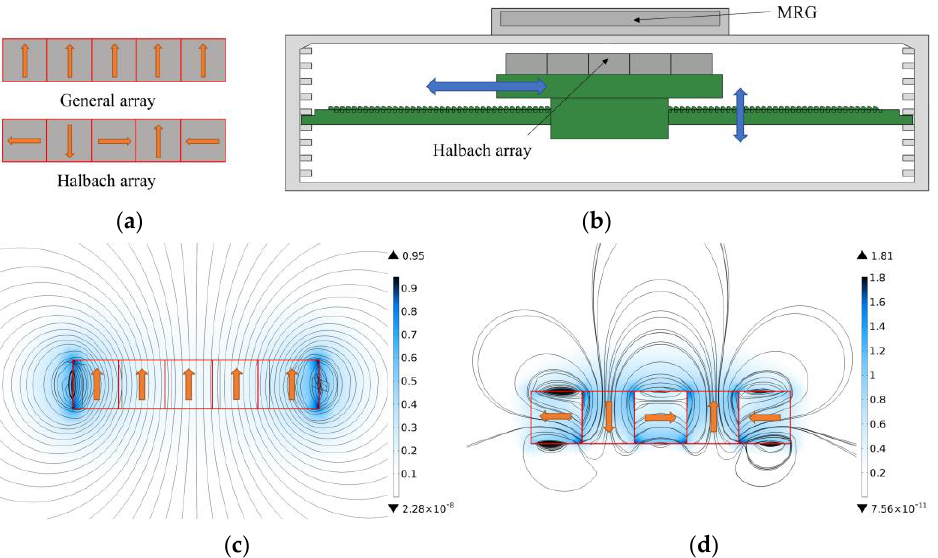
Figure 6. The effect of the arrangement and distance of the permanent magnets on the MRG layer. ( a ) Two different arrays of permanent magnets (the arrow indicates the direction of movement); ( b ) The effect of the lateral and longitudinal movement of the Halbach array on the MRG layer; ( c ) Magnetic field effect diagram of an ordinary array of permanent magnets; ( d ) Magnetic field rendering of Halbach array. Where the direction of the arrow is the direction of the magnetic flux of the permanent